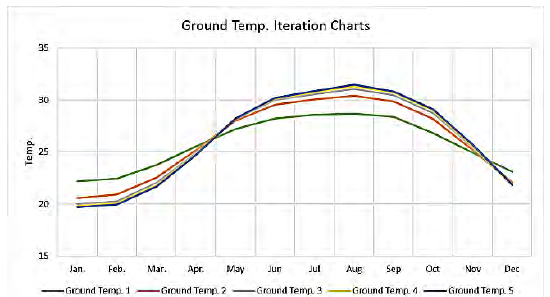
Figure 9. The basement zone’s adjacencies conditions.